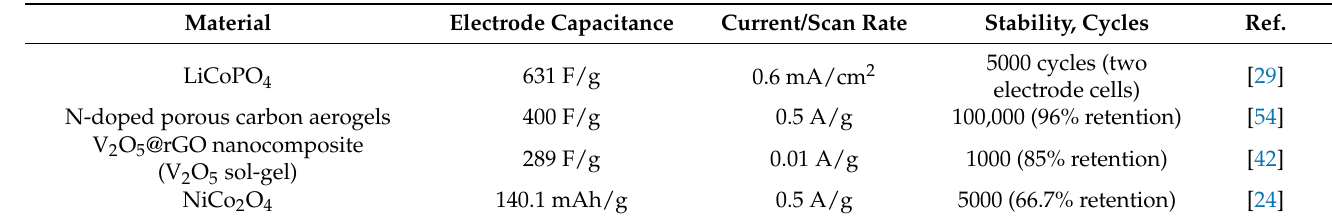
Table 1. Characteristics of some supercapacitor electrodes based on sol-gel